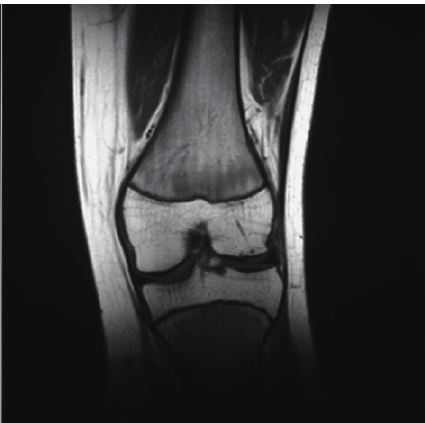
Figure 4: Postoperative MRI image showing consolidation of the osteochondral fragment and biodegradation of the pins in an 11- year-old patient at one-year